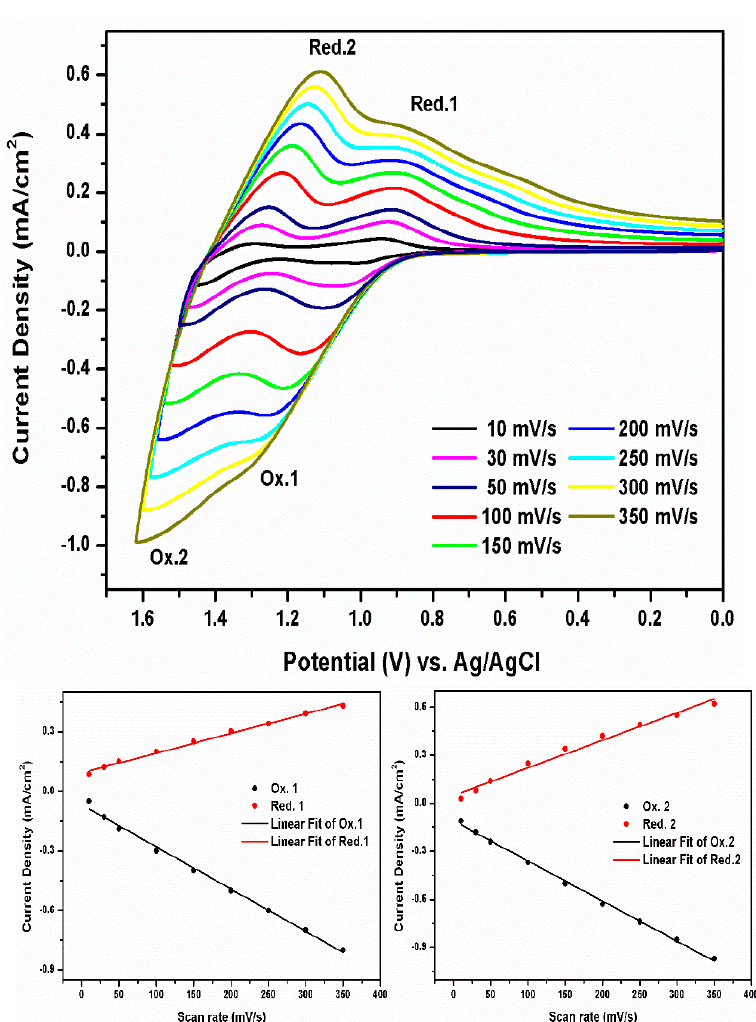
Figure 15. Scan rate dependence of ( a ) TPA–TPPI and ( b ) NPC–TPPI films on the ITO-coated glass slide in CH 2 Cl 2 containing 0.1 M Bu 4 NClO 4 at different scan rates between 10 and 350 mV s − 1 .